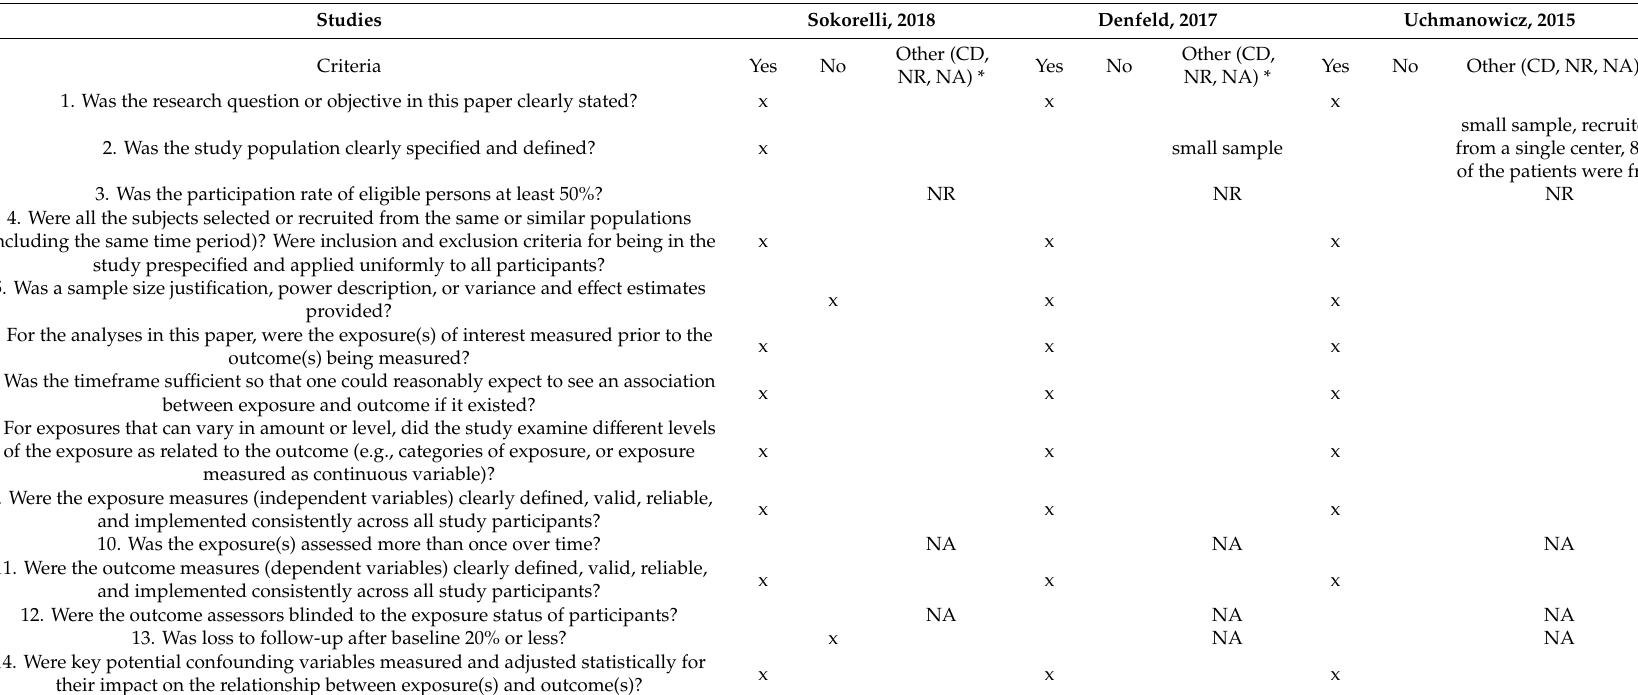
Table 2. Quality Assessment Tool for Observational Cohort and Cross-Sectional Studies, NHLBI (National Heart, Lung and Blood Institute), NIH (National Institute of